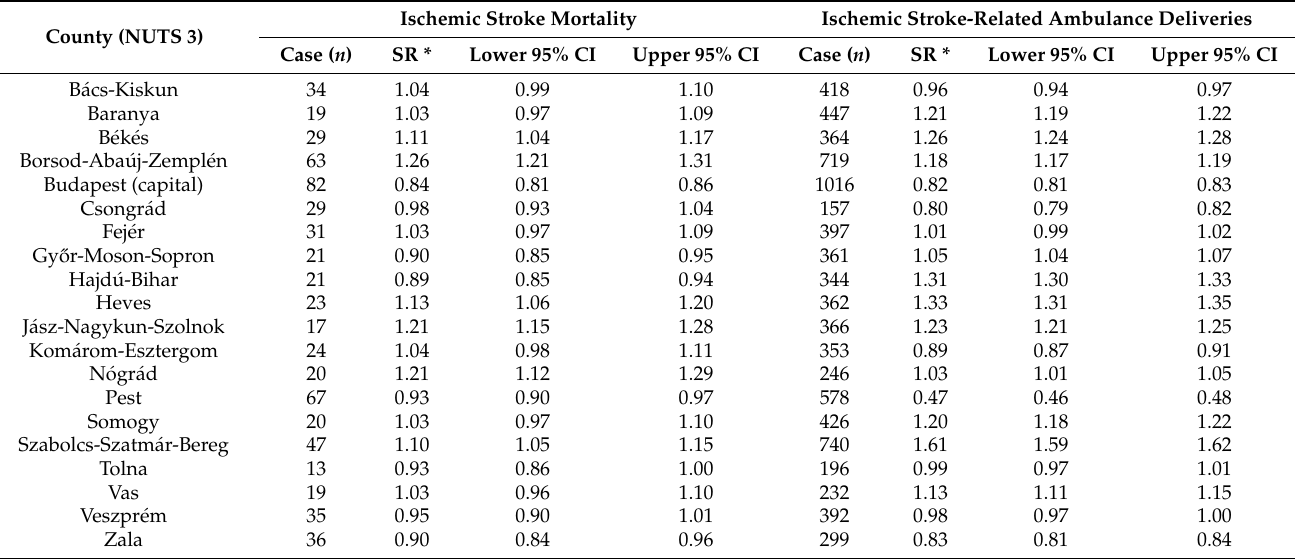
Table 4. Ischemic stroke mortality and ischemic stroke-related ambulance deliveries in Hungary, 2018. Ischemic Stroke County (NUTS 3)